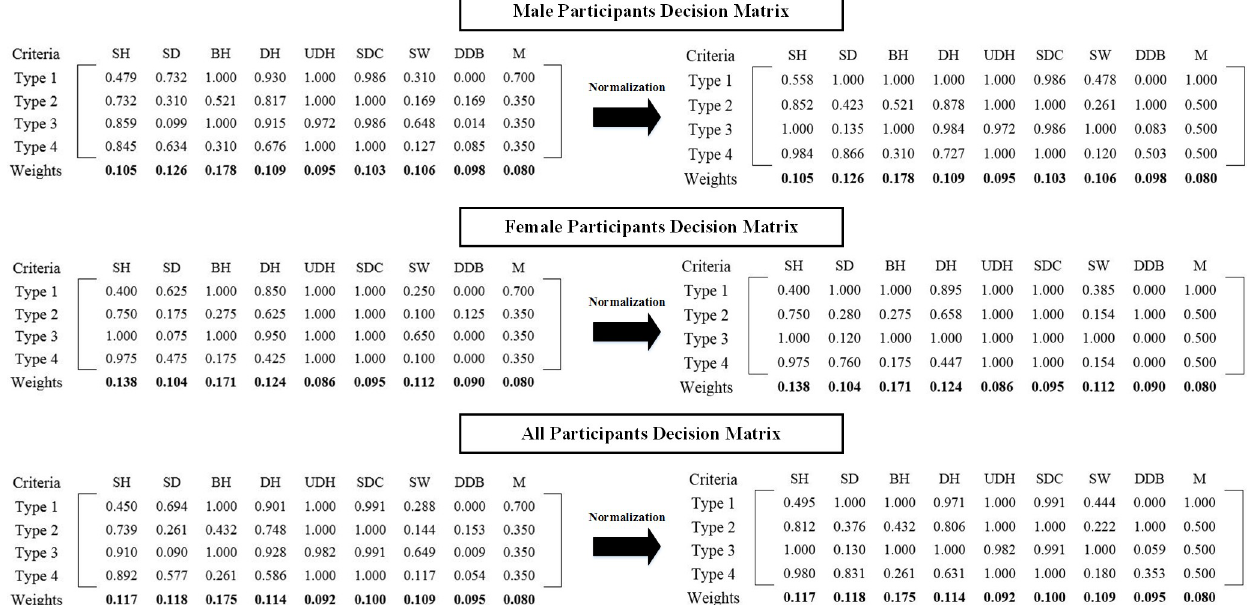
Fig 8. Decision making matrices for male, female and all participants before and after normalization.